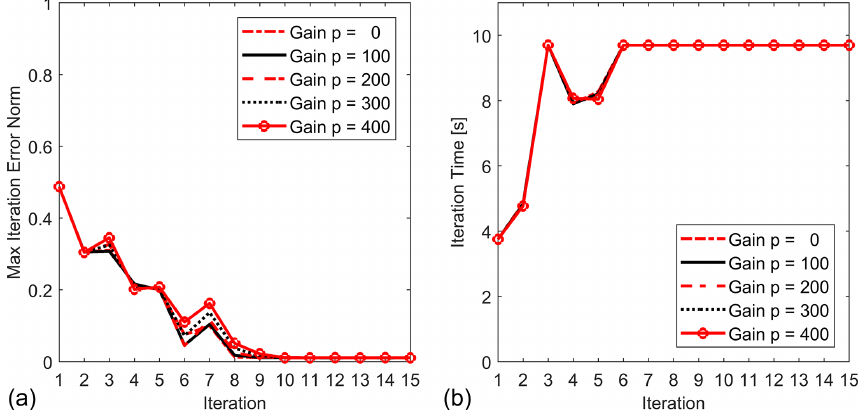
Figure 6. Convergence comparison of the ILC process for Trajectory A for different values of the fine-tuning gain p and multiplier gain s = 2: (a) maximum tracking error and (b) iteration